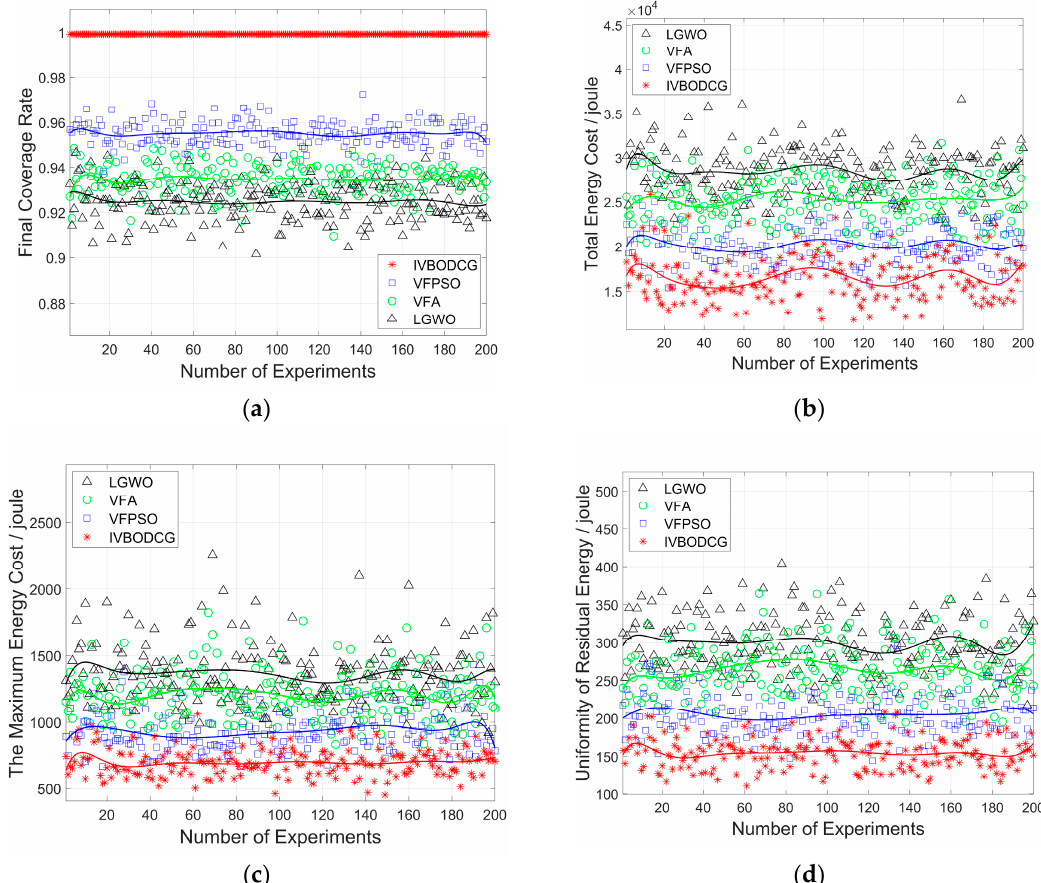
Figure 14. Comparison of energy cost and final coverage rate by 200 independent experiments. ( a – d ) show the final coverage rate, total energy cost, the maximum energy cost and uniformity of residual energy of four algorithms in 200 independent experiments, respectively. The curve is the fitting result of the tenth polynomial of the data points.